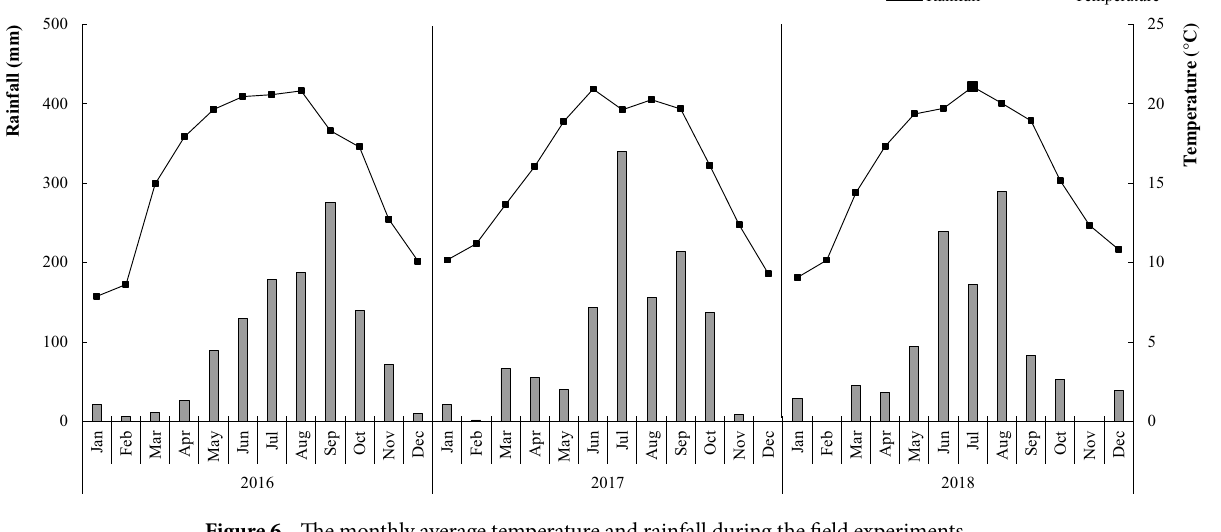
Figure 6. The monthly average temperature and rainfall during the field